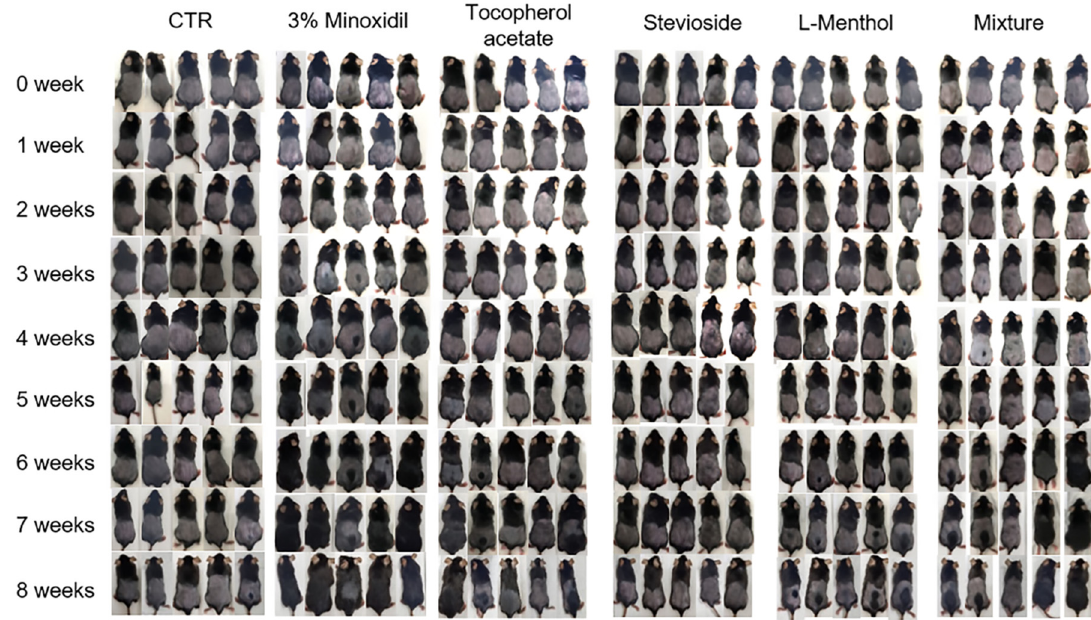
Figure 2. Effects of topical application of tocopherol acetate, stevioside, L-menthol, and their mixture on hair growth induction in C57BL/6 mice. Mice were divided into 6 groups: CTR (control), minoxidil, L-menthol, tocopherol acetate, stevioside, and L-menthol + tocopherol acetate + stevioside. Time scale of hair regrowth in C57BL/6 mice during 8 weeks post-shaving. The skin on the back of each mouse was photographed every week.